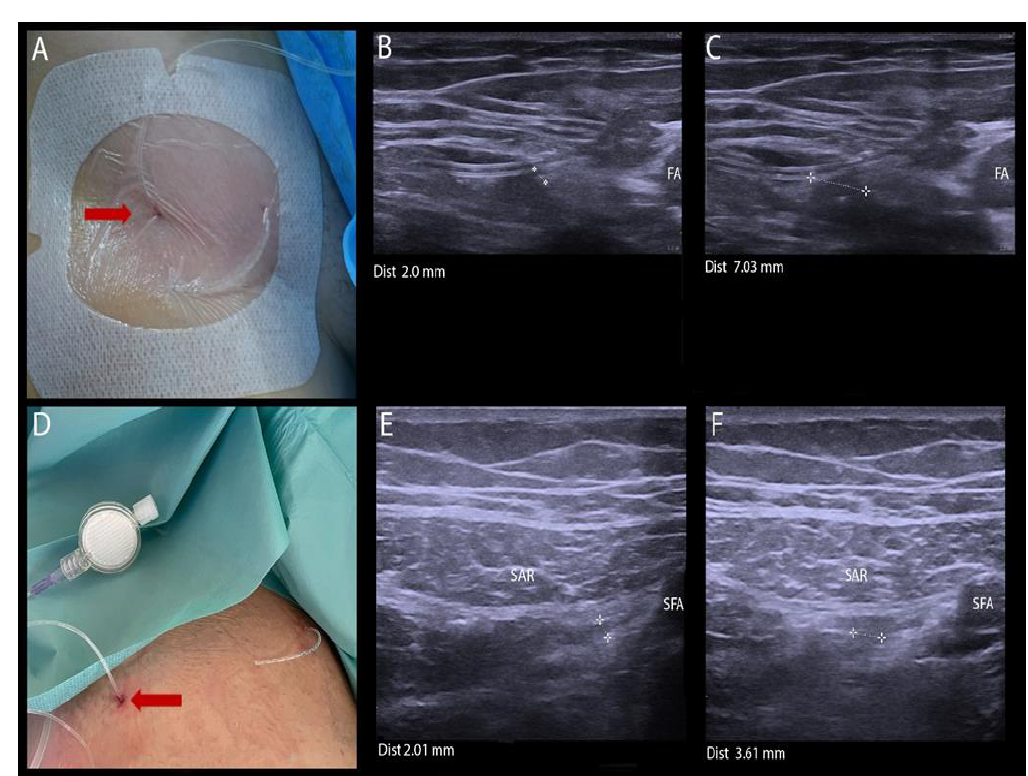
Figure 2. Insertion of SMC. ( A ) CFNB. The catheter was placed with its orifices brought 0.2 cm from the femoral nerve under ultrasound guidance. The catheter proximal and distal ends are visualized. Importantly, the catheter may be repositioned by pulling at the latter. ( B ) The catheter placed for CFNB. The distance between the femoral nerve and catheter orifice was 0.2 cm. ( C ) CFNB catheter after 24 h. The distance between the catheter and orifice was 0.7 cm. No spread of ropivacaine bolus towards the femoral nerve was visualized. There was no reduction in pain intensity following bolus administration. The catheter was then pulled and the catheter orifice placed near the femoral nerve. ( D ) CFTB. The catheter was placed according to the same procedure, using catheter set with a suture-needle with the curvature radius of 7.5 cm. The catheter orifices were placed 2 mm from the saphenous nerve. ( E ) Ultrasound scan of CFTB after catheter insertion. A catheter orifice was placed near the saphenous nerve. The distance between the saphenous nerve and orifice was 0.2 cm. ( F ) Ultrasound scan of CFTB after 24 h. The distance between the saphenous nerve and catheter orifice was 0.4 cm. A bolus of ropivacaine is seen spreading towards the nerve. Arrow indicates the site of punction. Abbreviations: SAR—sartorius muscle; FA—femoral artery; SFA—superficial femoral artery.